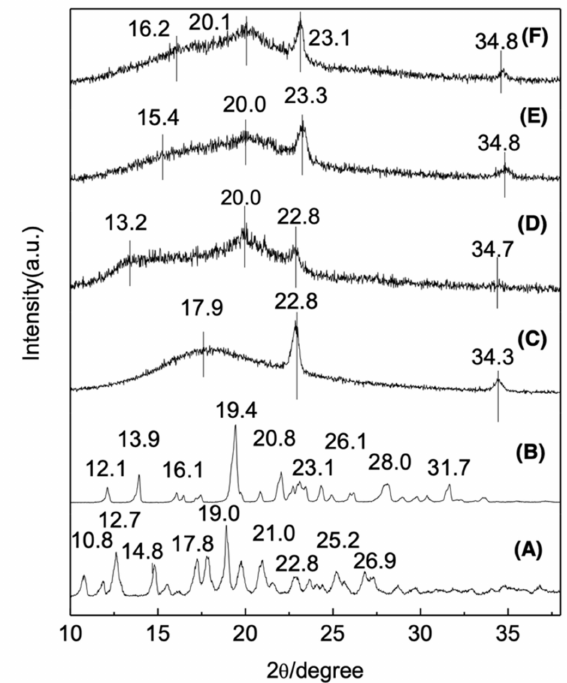
Figure 3. XRD patterns of ( A ) α -CD, ( B ) ODA, ( C ) ODA-PHA, ( D ) α -CD/ODA-PHA, ( E ) β -CD/ODA- PHA, and ( F ) γ